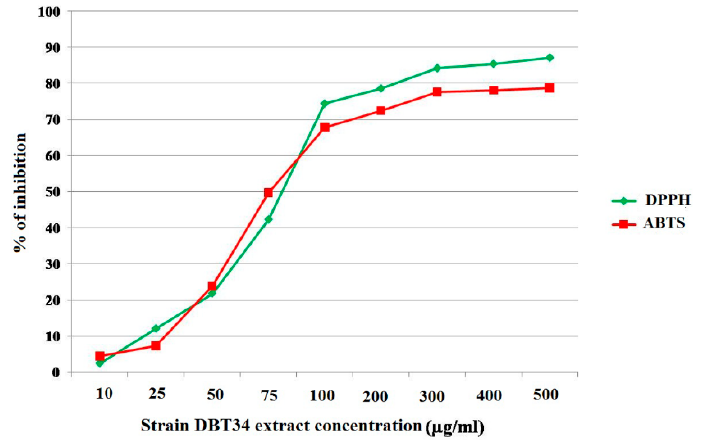
Figure 3. DPPH and ABTS radical scavenging activity of the methanolic extract of Streptomyces sp. strain DBT34.